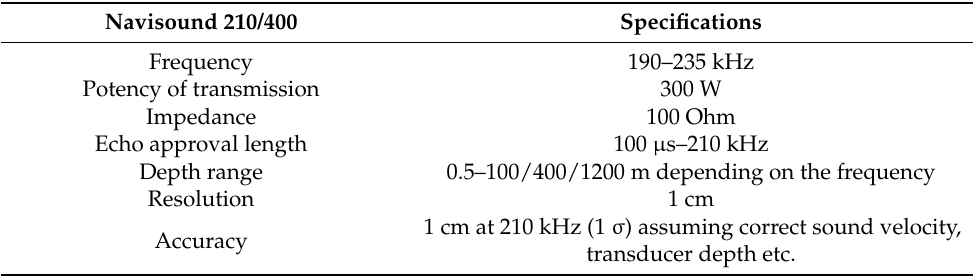
Table 1. Characteristics of echo sounder Navisound 210.